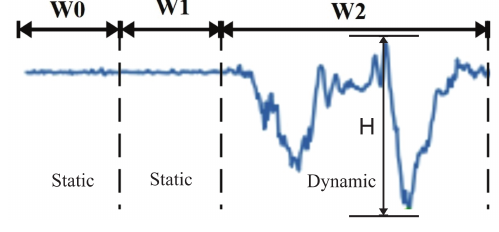
Fig 10. Data correlation window.